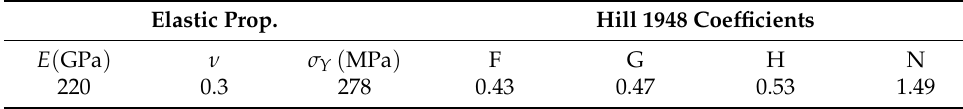
Table 6. Mechanical properties of the DD13 material [32]. Elastic Prop.